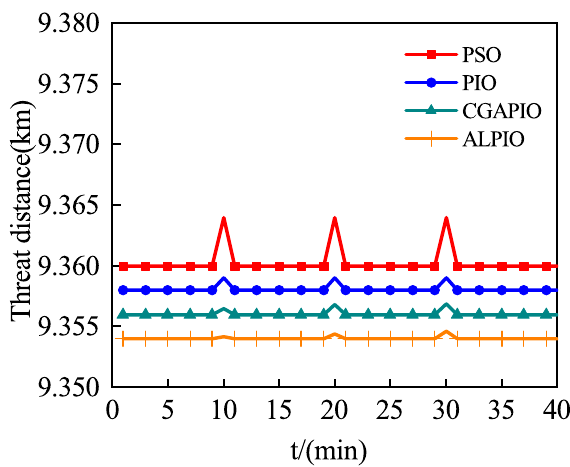
Figure 17. Schematic of threat distance for different